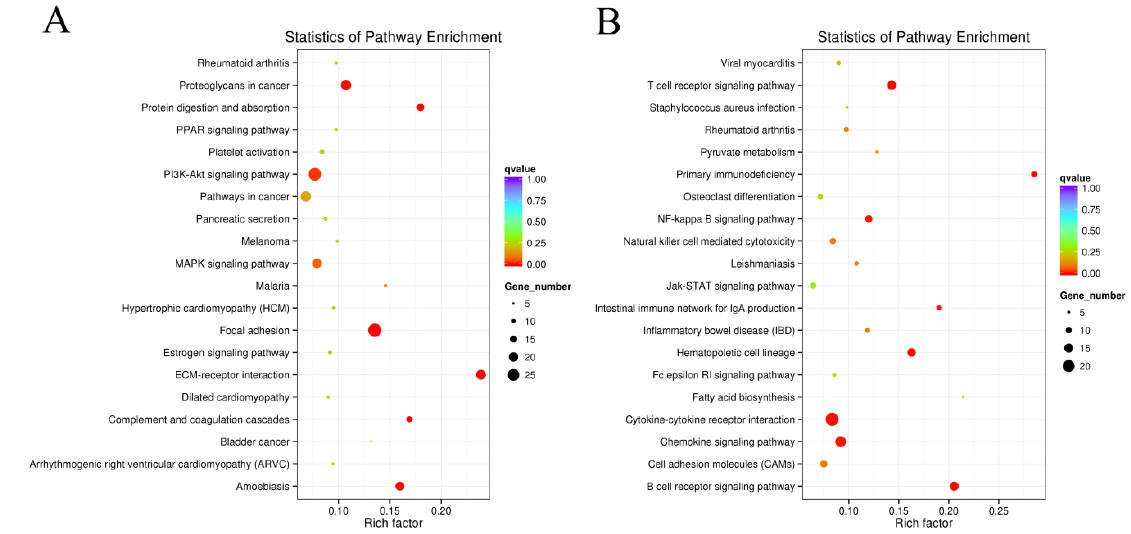
Figure 3. KEGG analysis of the DEGs. ( A ) Top 20 upregulated signaling pathways in KEGG enrichment analysis in ob/ob mice. ( B ) Top 20 downregulated signaling pathways in KEGG enrichment analysis in ob/ob mice.